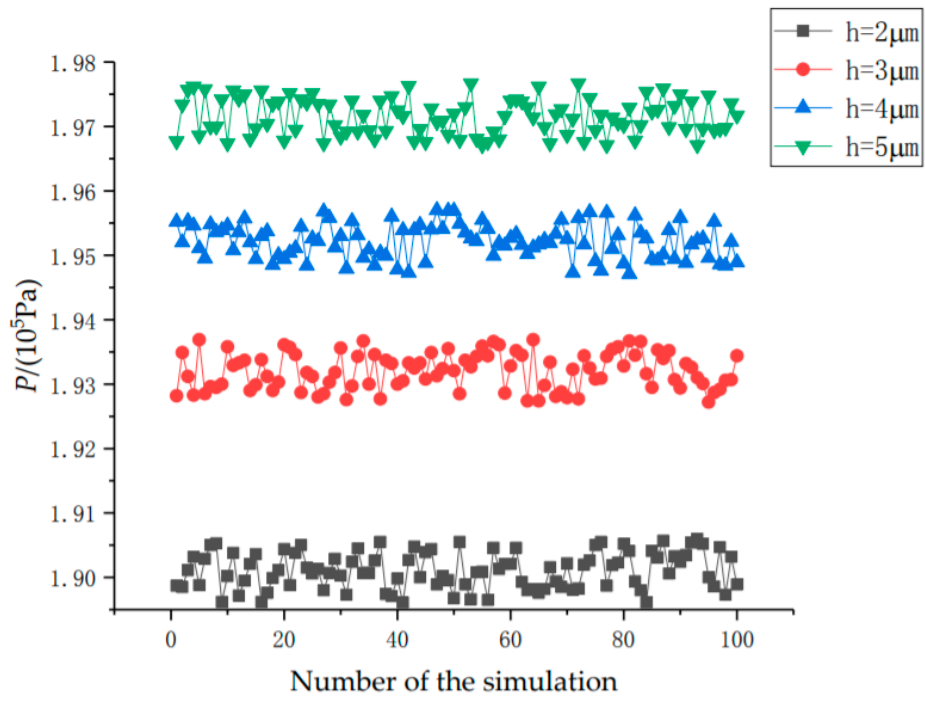
Figure 14. Pressure fluctuation diagram under different fluid films.